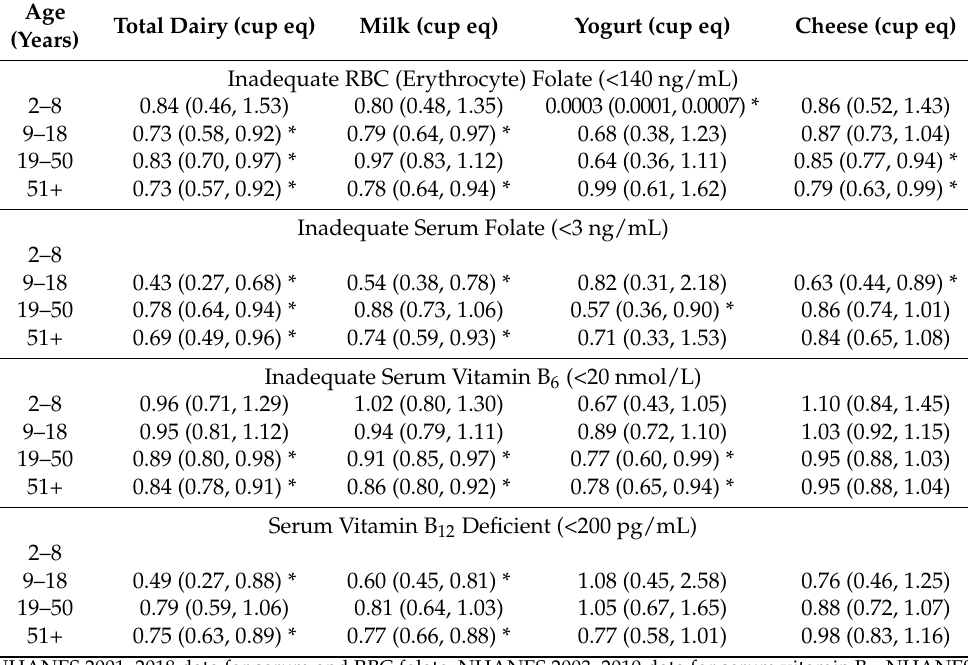
Table 6. Linear trends in odds ratios (OR), 99% upper and lower confidence limits (UCL, LCL) for vitamins deficiency/inadequacy across consumer quartiles of intake by age group. Gender-combined